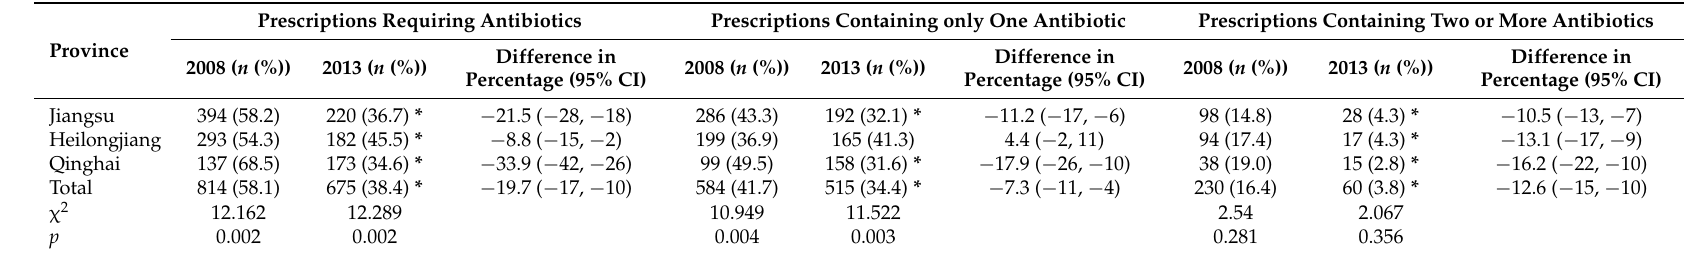
Table 5. Antibiotic prescriptions in township outpatient